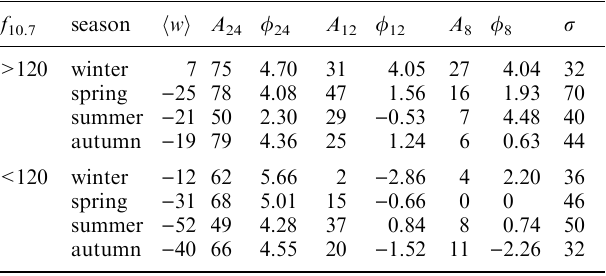
Table 6. Harmonic decomposition at 185 km height. Amplitudes, mean wind, and the standard deviation are in m (cid:225) s ) 1 , phases in hours (likewise for Tables 7–13)